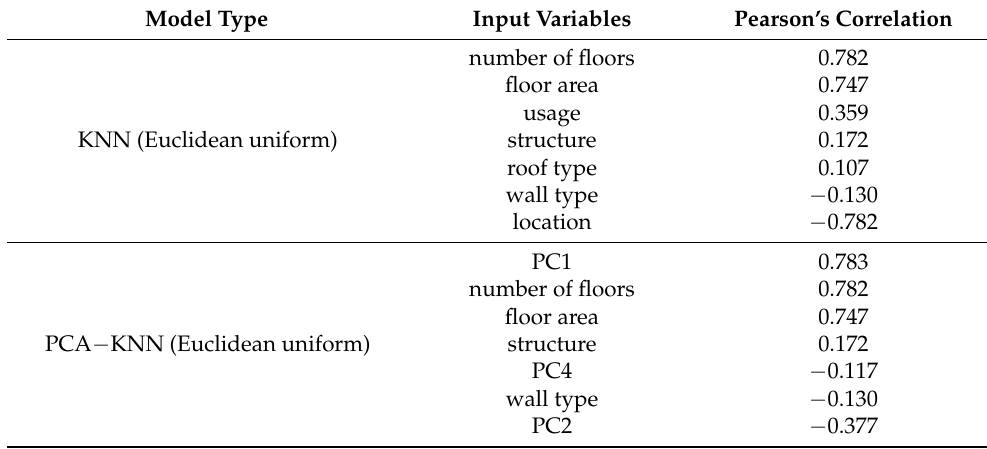
Table 5. Pearson’s correlation analysis of the input variables used to develop the KNN (Euclidean uniform) and PCA − KNN (Euclidean uniform)